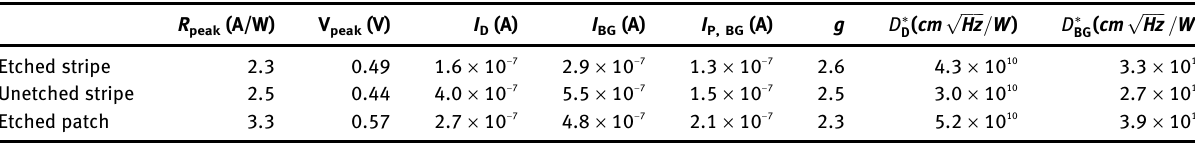
Table  : DetectorpropertiesforetchedandunetchedstripedetectorsfromFigures  D,E,andwiredpatchantennasfromRef.[  ].Valuestaken at conditions corresponding to R peak